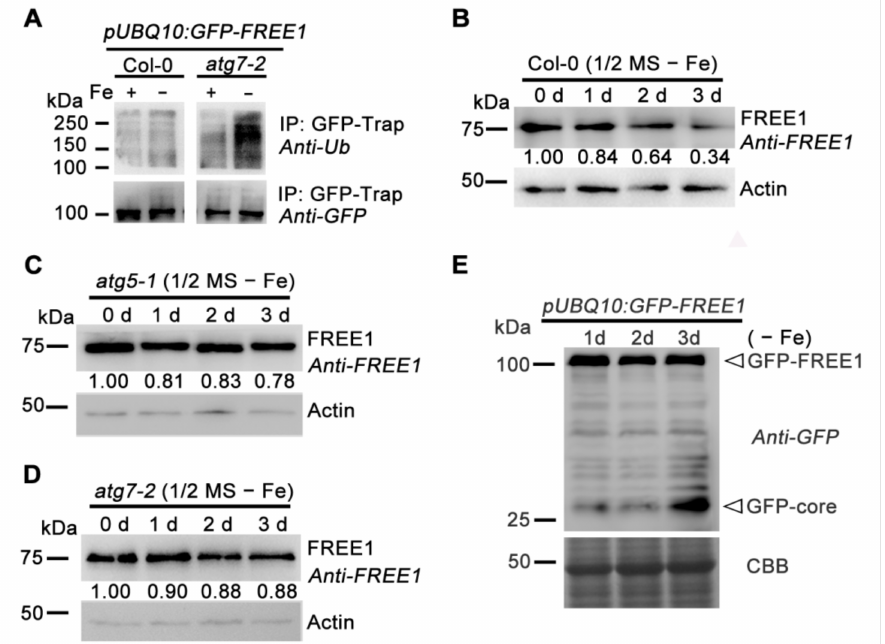
Figure 3. Autophagy positively regulates the degradation of FREE1 in response to iron-deficiency. ( A ) The total ubiquitination of GFP-FREE1 in response to iron starvation in Col-0, atg7-2 backgrounds. Seven-d-old plants expressing pUBQ10:GFP-FREE1 in the indicated backgrounds grown on 1/2 MS + Fe medium plates were treated with 1/2 MS + Fe or 1/2 MS − Fe liquid medium for 1.5 d before harvesting to perform protein extraction followed by immunoprecipitation (IP) with a GFP- trap. Finally, the IP fractions were subjected to immunoblot analysis with the indicated antibodies. ( B – D ) Endogenous FREE1 levels in 7-d-old Col-0, atg5-1 and atg7-2 seedlings upon iron starvation exposure for 0 d, 1 d, 2 d and 3 d, respectively. ( E ) The 5-d-old plants over expressing pUBQ10:GFP- FREE1 upon iron starvation exposure for 1 d, 2 d and 3 d were used for protein extraction followed by detection with a GFP